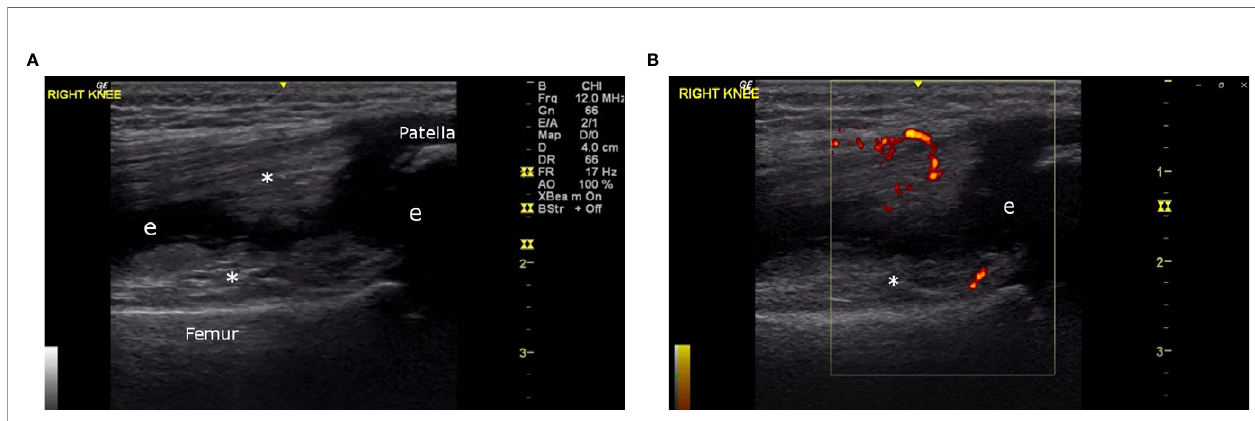
FIGURE 5 | (A) Right knee, superior longitudinal view, greyscale (6 year old male, Case 2), demonstrating abundant proliferative synovitis (*) and effusion (e). (B) Right knee, superior longitudinal view, color Doppler (6 year old male, Case 2), demonstrating proliferative synovitis with intense 3+ Doppler signal